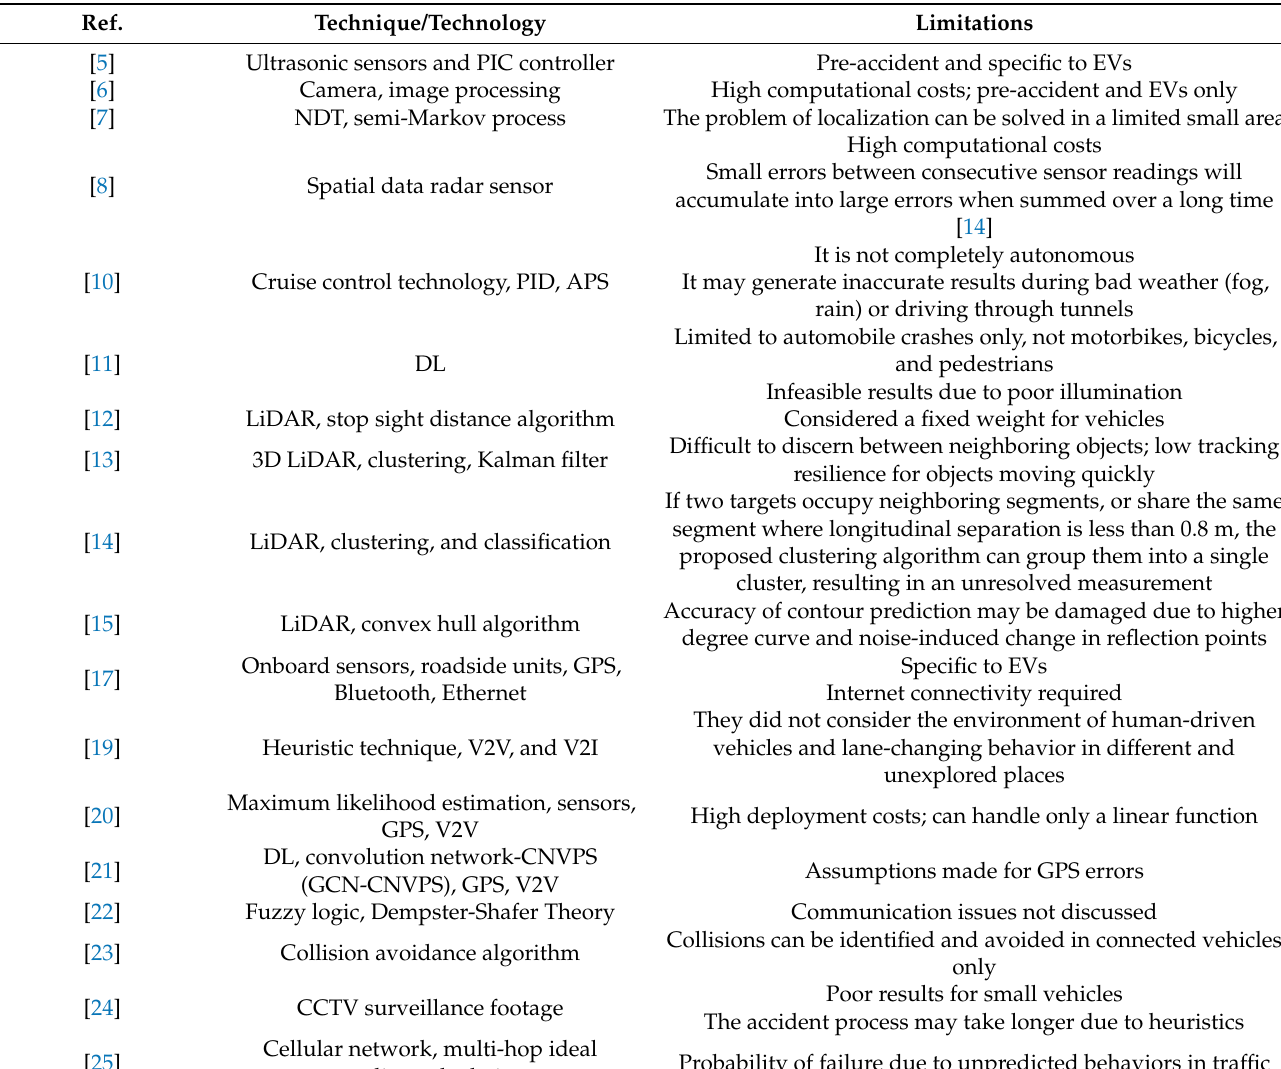
Table A1. State-of-the-art accident avoidance approaches.